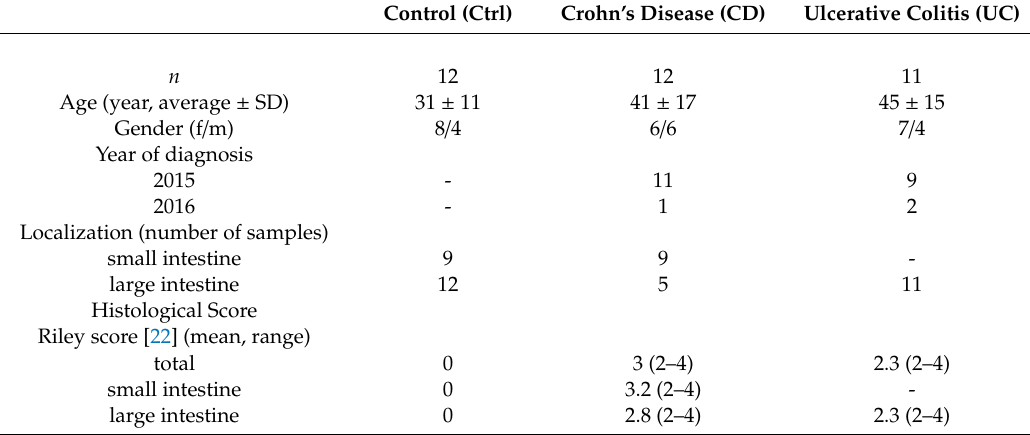
Table 1. Clinical features of the patient cohort and origin of biopsies. Patients with active inflammatory bowel disease (IBD) (Crohn’s disease (CD) and ulcerative colitis (UC)) were included, and histological samples from di ff erent intestinal localizations were compared with corresponding (non-IBD) control tissue samples. Histological grading was performed using the Riley